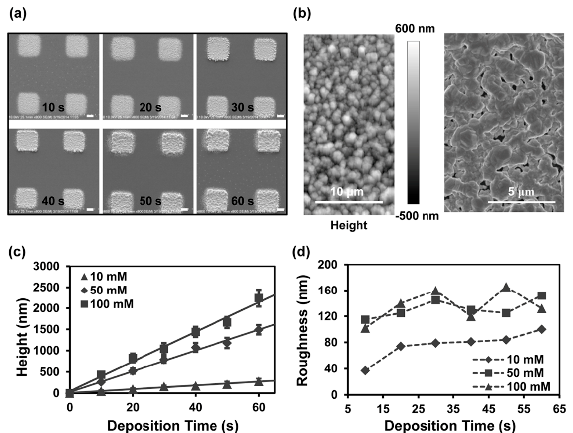
Figure 11. ( a ) Fabricated microelectrodes with respect to deposition time; scale bar: 10 µ m. ( b ) Surface roughness of microelectrode by atomic force microscope (AFM) and SEM. ( c ) Thickness and ( d ) surface roughness of microelectrodes with respect to deposition time and solution concentration (reproduced from Ref. [75]).